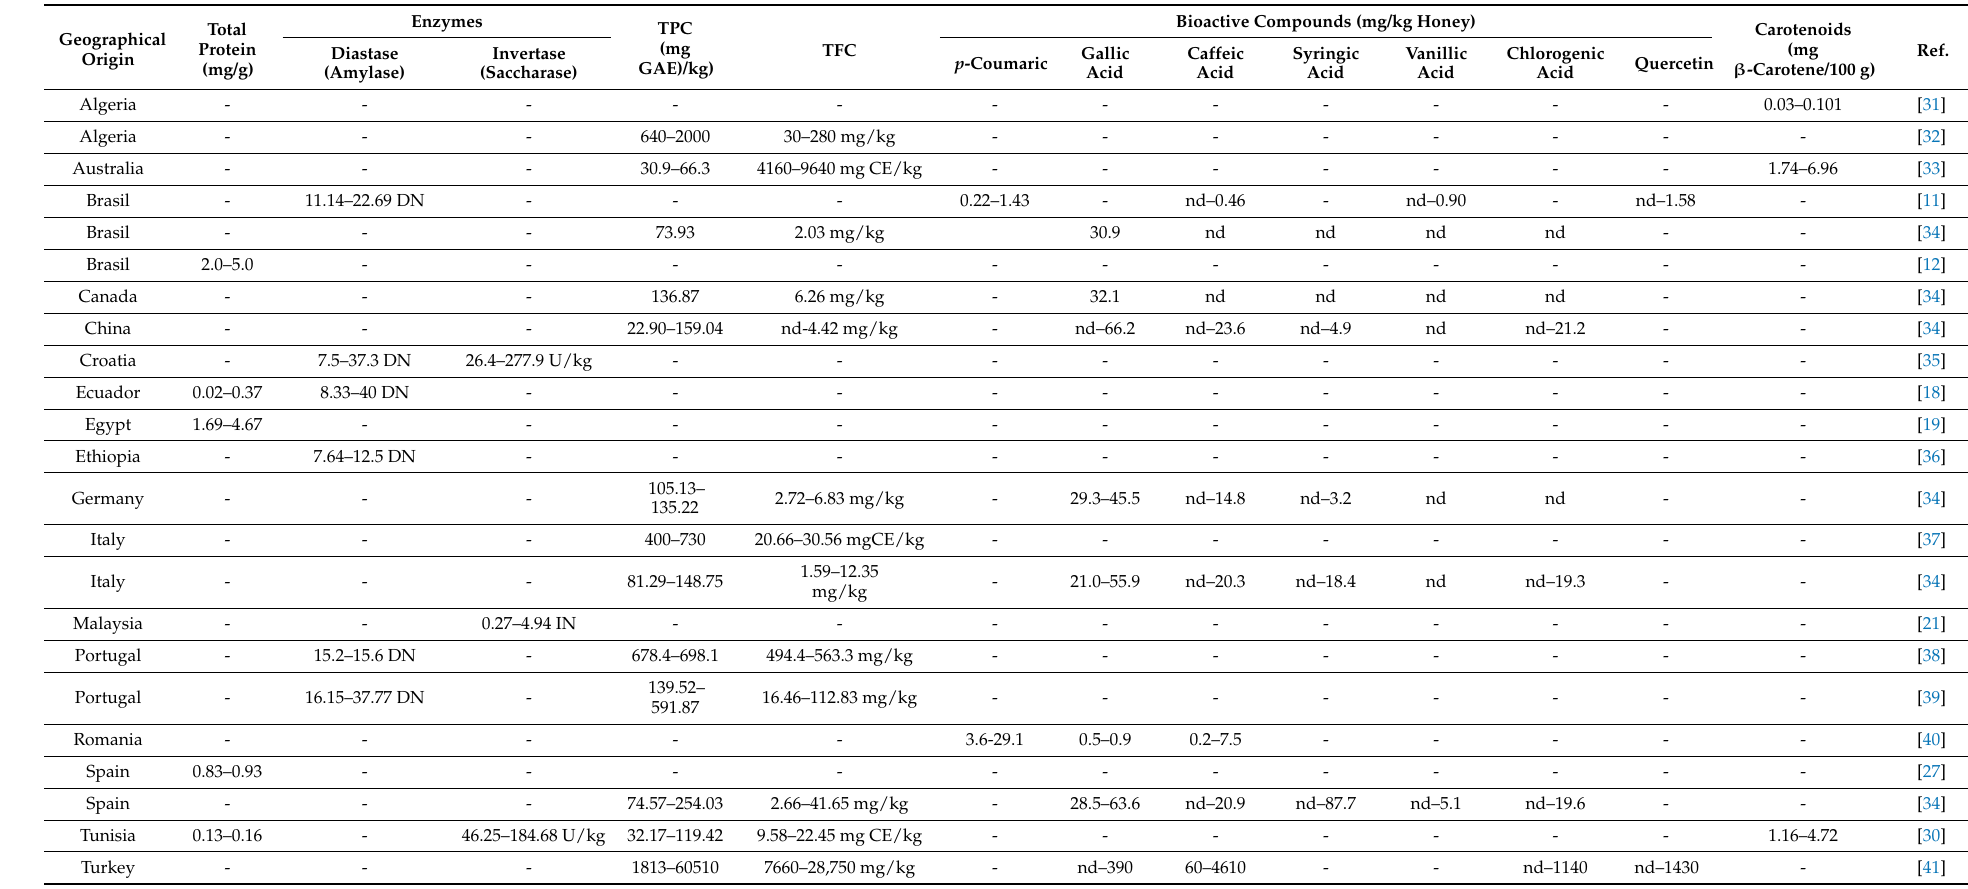
Table 2. Total proteins, enzymes, TPC, TFC, bioactive compounds and carotenoids of honey from different geographical